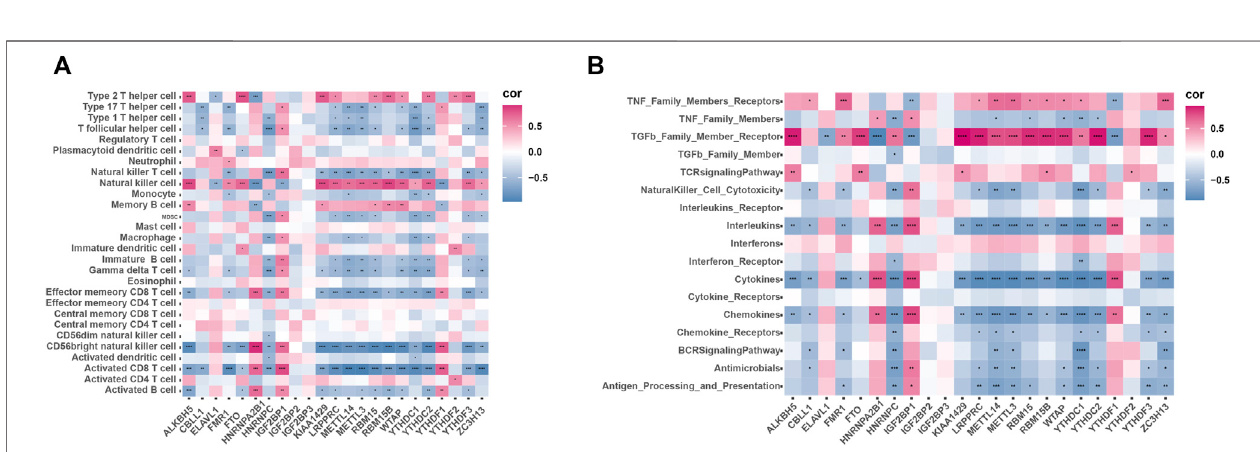
FIGURE 6 | Correlation of in fi ltrating immune cells, immune response genes and m6A regulators. (A) Dot plot shows the correlation between each immune microenvironmentaberrantin fi ltratingcelltypeandeachabnormalm6Aregulator. (B) Dotplotshowsthecorrelationbetweeneachimmuneresponsegenomeandeach M6A